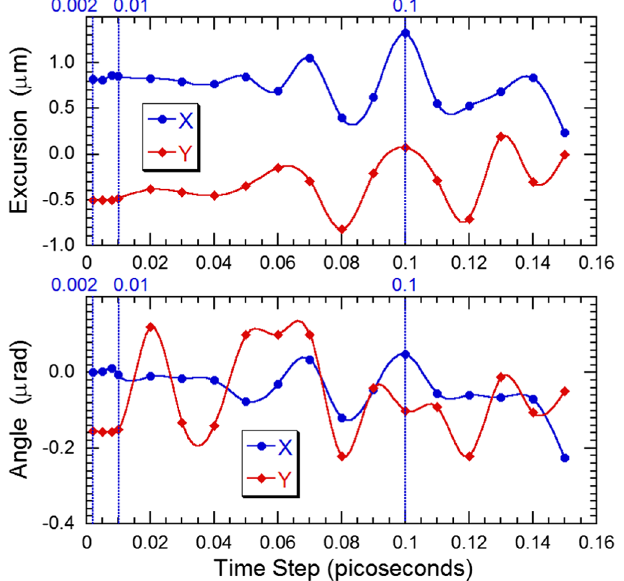
3. Beam excursions and angles at the exit of the snake as a function of time-step used for numerical calculations using Blewett-Chasman fields, for a 120 GeV = c beam entering the snake